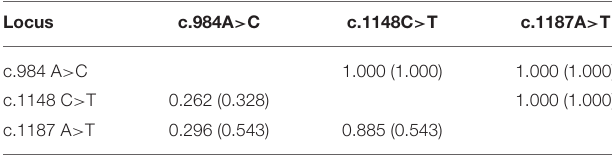
TABLE 5 | Linkage disequilibrium analysis among three SNP of Mm-BCDO2 gene. Locus